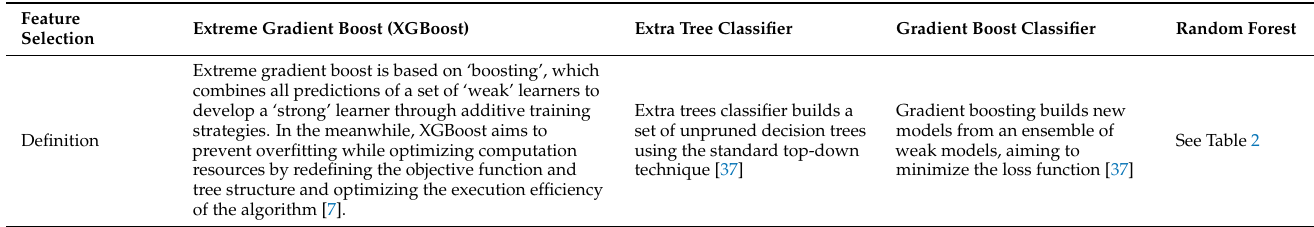
Table 3. The usage of machine learning methods to select important